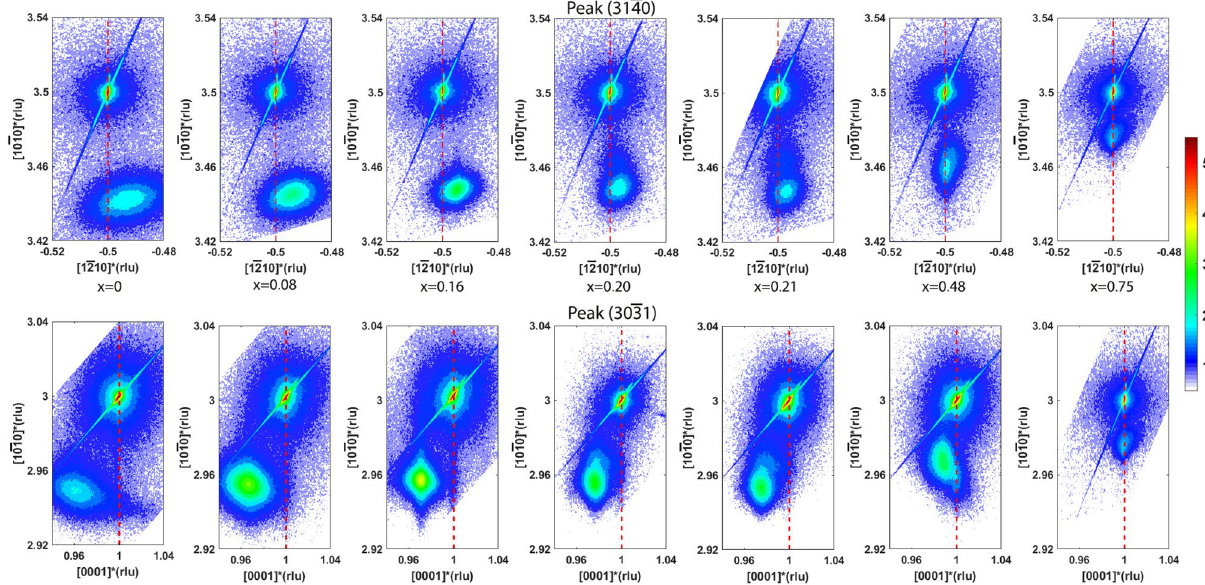
Figure 7. Reciprocal Space Maps (RSM) around the ( 31 ¯ 40 ) peak (top row) and ( 30 ¯ 31 ) peak (bottom row) of the Y-cut quartz substrates also displaying the Si x Ge 1 − x O 2 film peaks. The vertical axes represent the Y-direction and the horizontal axes represent the X- and Z- directions in the top and bottom rows, respectively. The color bar indicates the x-ray intensity (log. scale) in counts per